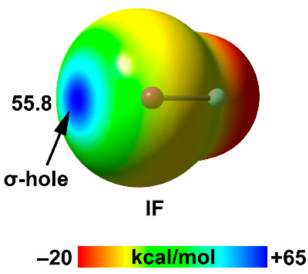
Figure 16. MEP surfaces of IF using the 0.001 a.u. isosurface and the MP2/def2-TZVP level of theory (energy in